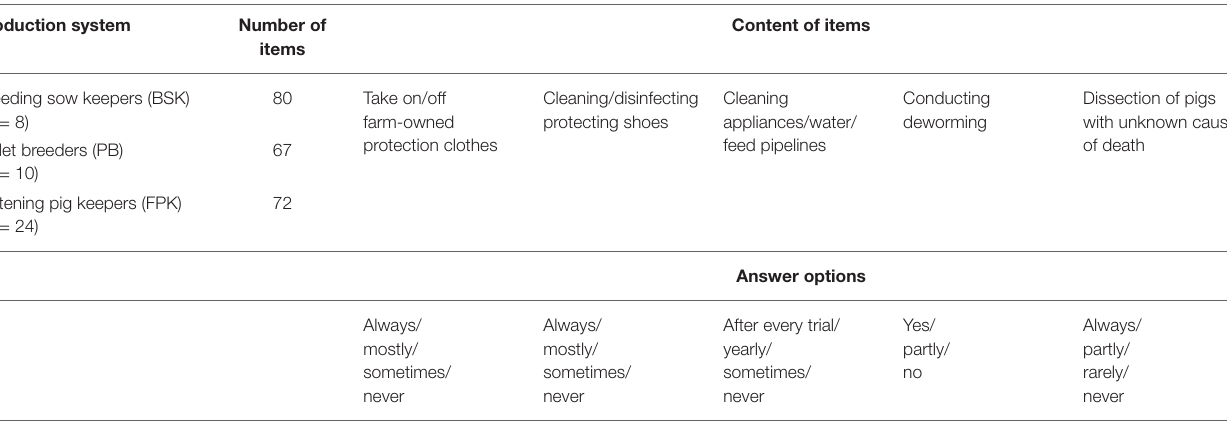
TABLE 3 | Number of items according to the production systems and content examples of items related to the “continuous animal hygiene index” (CAHI). Production system